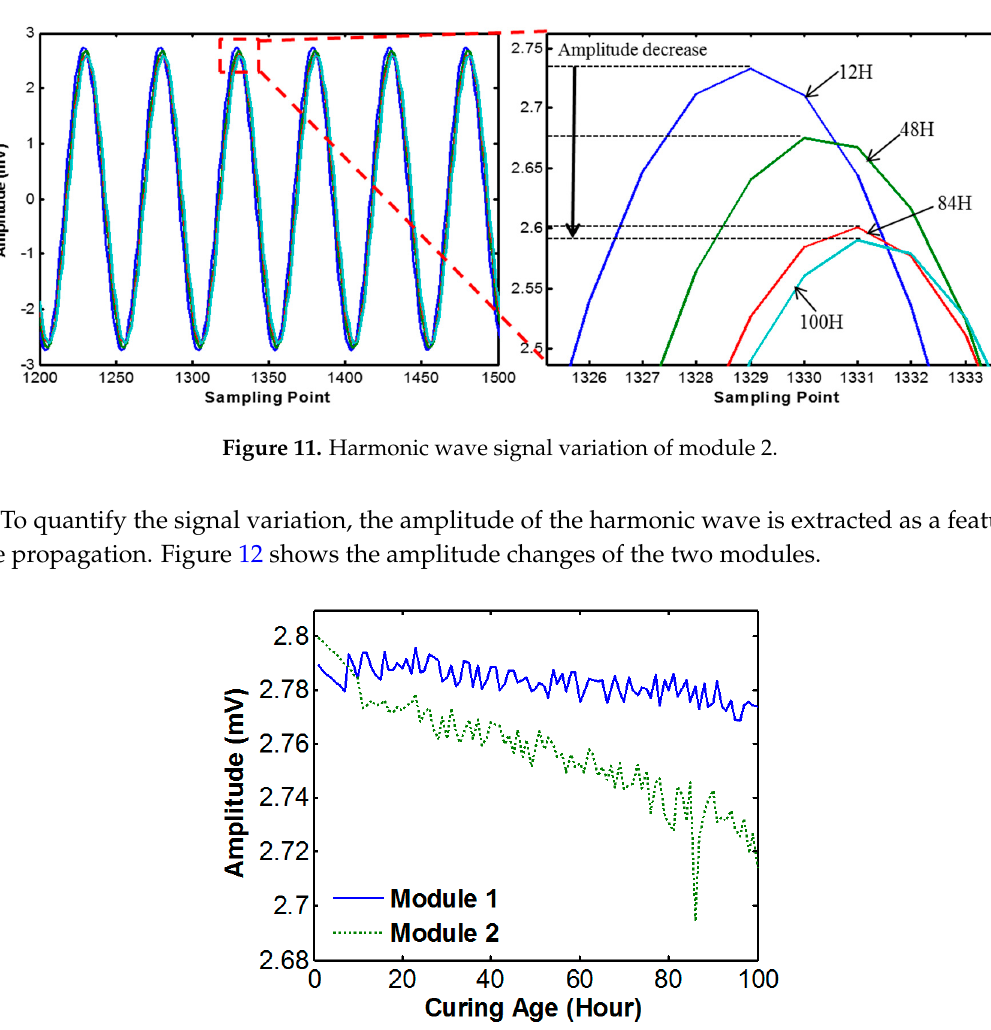
Figure 12. Wave propagation amplitude change during the early-age of the curing stage.